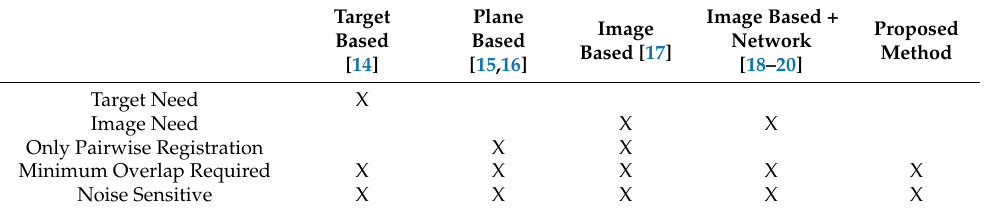
Table 1. Comparison between different registration approaches, including our proposed